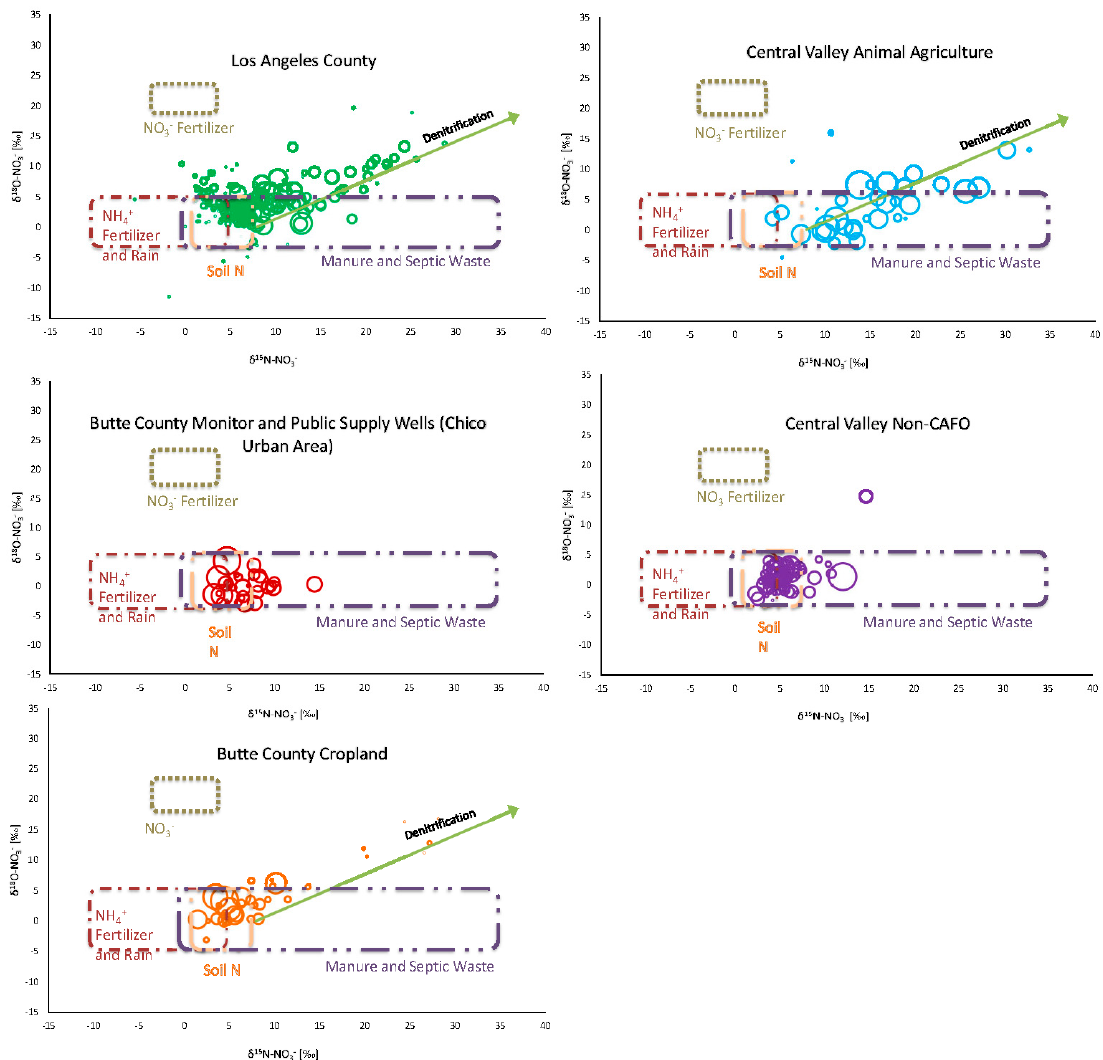
Figure 8. Dual nitrate isotope plots for the five sample groupings, with sample points scaled for nitrate concentration. Denitrification trends are evident in the Central Valley dairy, Butte Country Agriculture, and LA County samples. Two sources can be inferred from the Los Angeles plot: lower [NO 3 − ] clustered around 2-4 δ 15 N-NO 3 − likely representing background levels from natural processes, and higher [NO 3 − ] forming between 5-12 δ 15 N-NO 3 − , likely from wastewater sources.